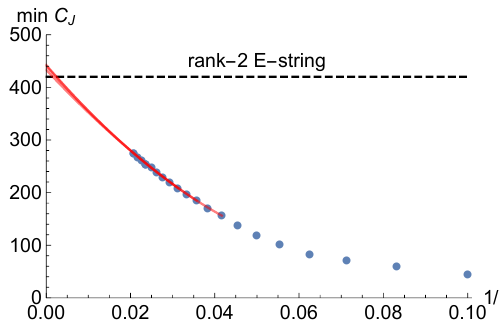
Figure 8 . The lower bounds on C J at di(cid:11)erent derivative orders (cid:3), for interacting theories with E 8 (cid:13)avor group and assuming C T = 151956 , which is the value in the rank-two E-string theory. Also 5 shown is an extrapolation to in(cid:12)nite derivative order using the quadratic ansatz (8.1) with (cid:3) (cid:21)